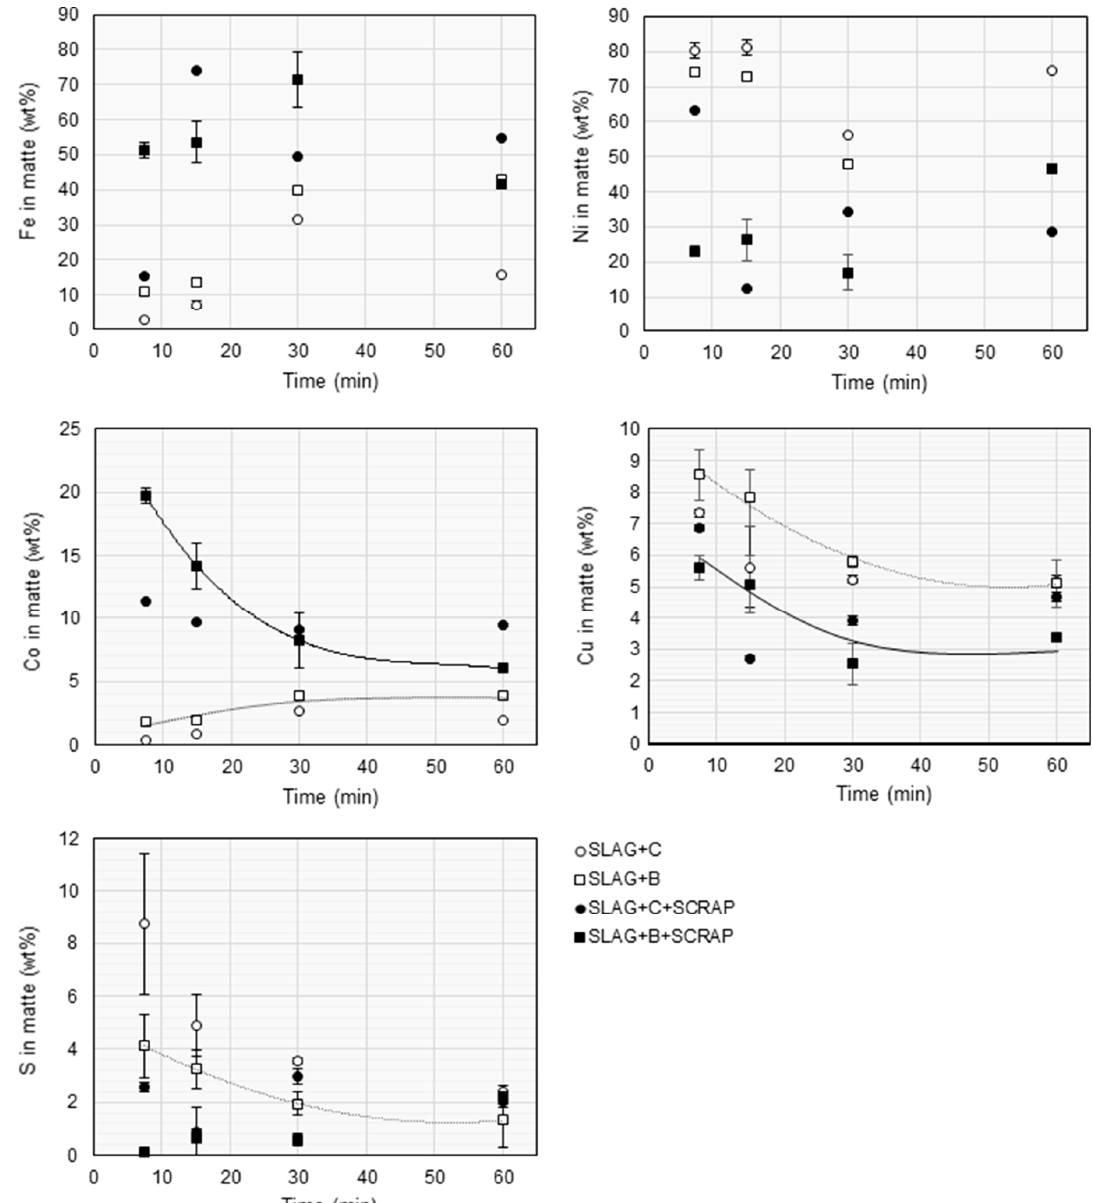
Figure 5. Iron, nickel, cobalt, copper and sulfur concentrations in matte as a function of reduction time at 1400 °C. Trend lines were drawn for biochar-containing reduction experiments: SLAG + B as dotted black line ( ∙∙∙ ) and SLAG + B + SCRAP as solid black line ( ‒ ).